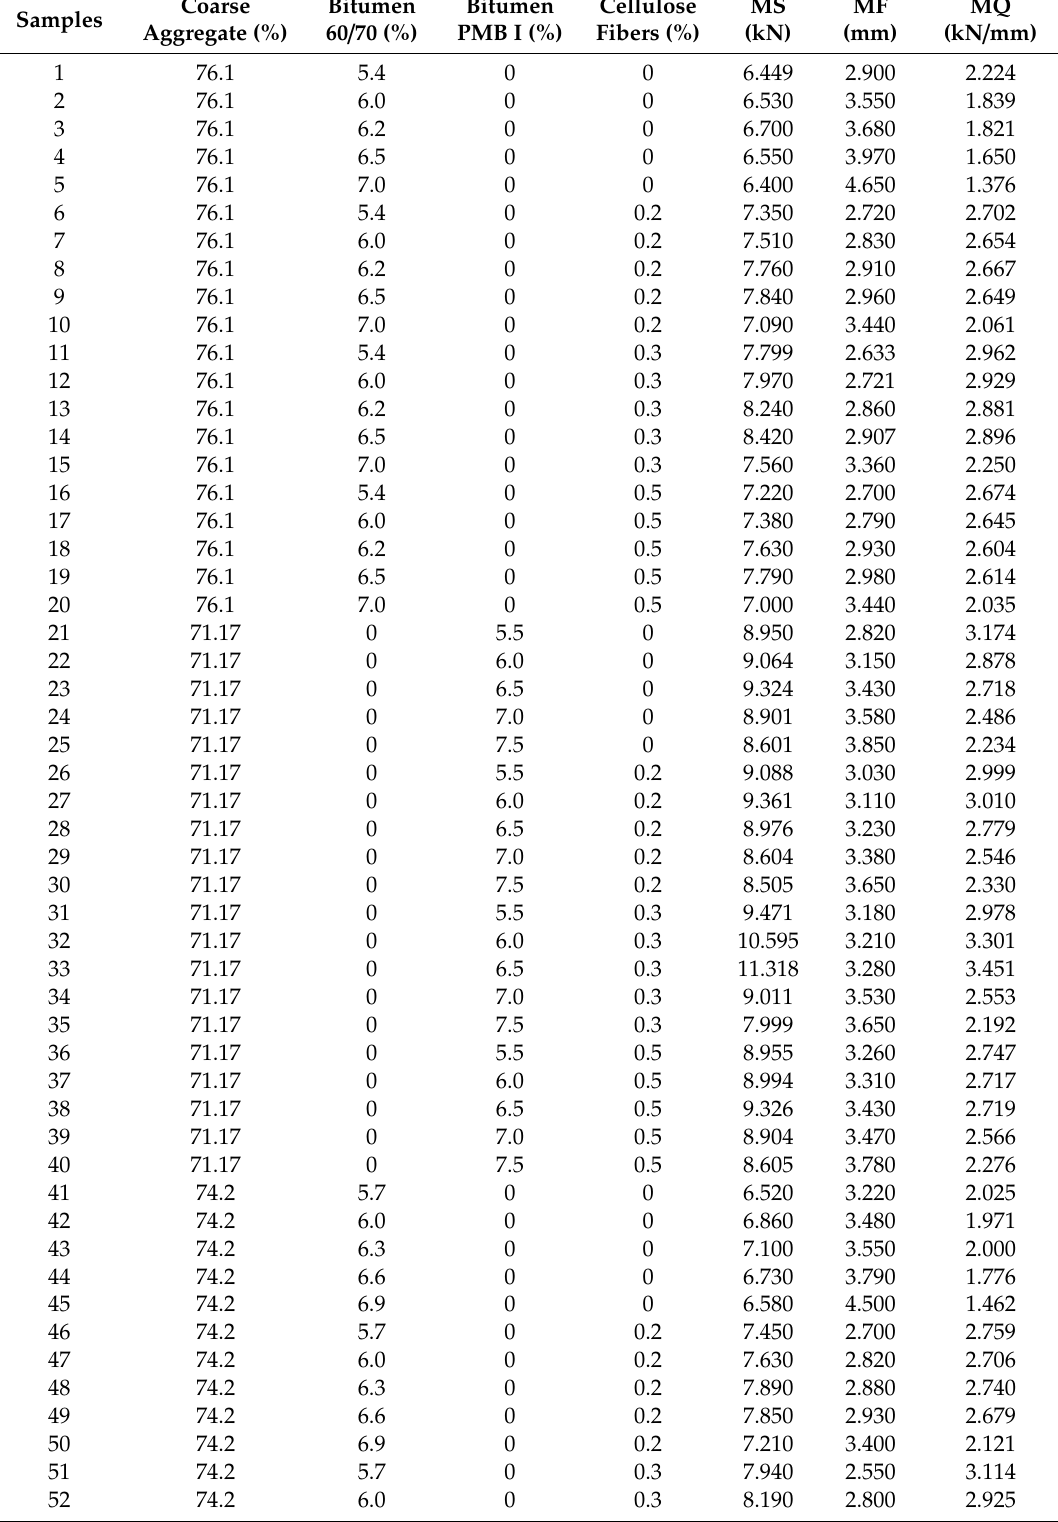
Table A1. The dataset used in this